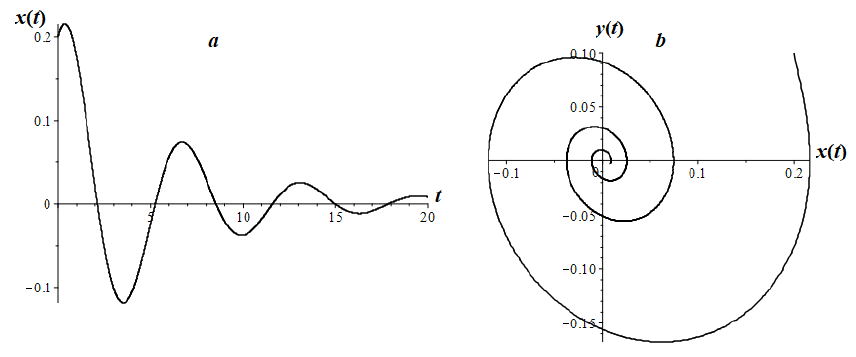
Figure 12. AHO, experiencing free oscillations without damping at β = 1.8: ( a ) oscillogram; ( b ) phase trajectory.